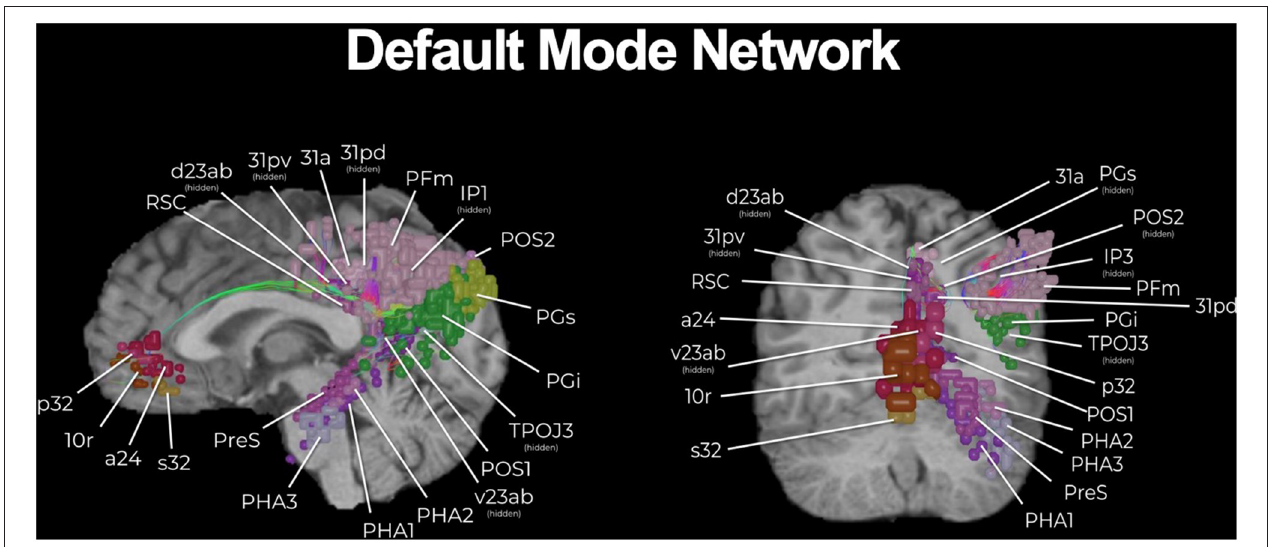
FIGURE 1 | The core of the default mode network (DMN). While a multi-lobar network, the core of the DMN is provided, including its key brain parcellations and connecting structural fibers. Individual regions have been visualized in 3D space and therefore some parcellations have been covered or require multiple views for correct spatial understanding due to parallax. Visualization of tracts have been minimized (thickness and volume) to maximize the visibility of